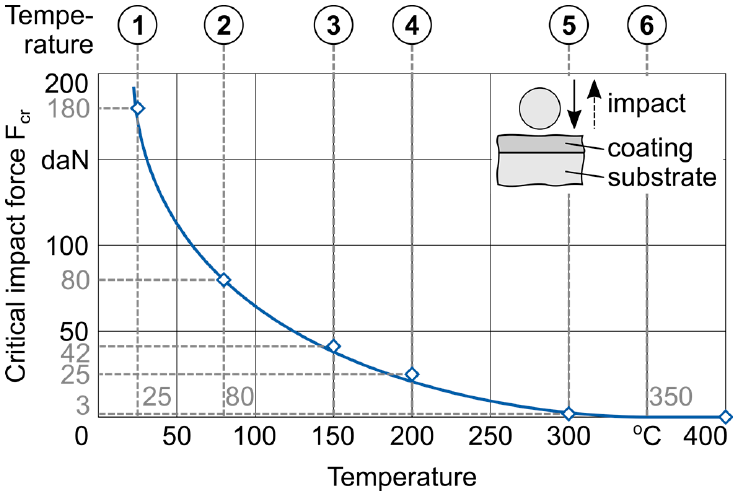
Figure 14. Critical impact force associated with coating fatigue endurance at 10 6 impacts versus temperature.